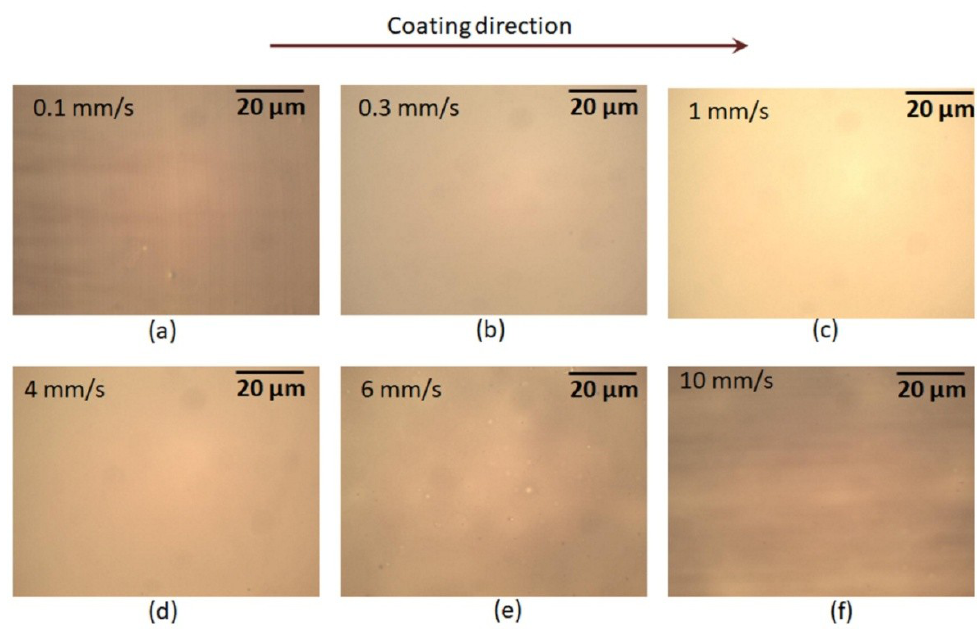
Figure 5. Optical images of PEDOT:PSS films that were deposited using the slot-die coating process at different coating speeds. The substrate temperature and flow rate were kept constant at 30 °C and 1 μL/s, respectively.